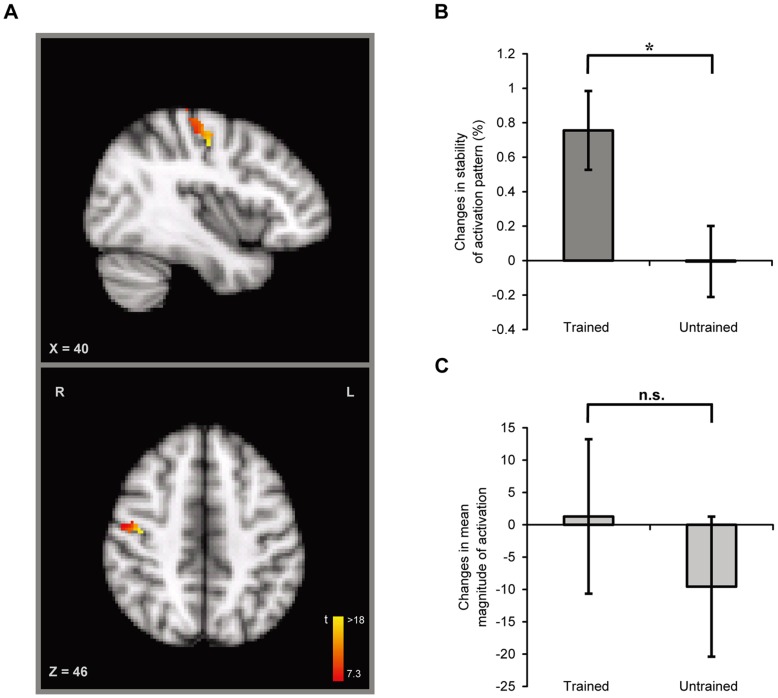
ROI-based Analyses.A) The right primary motor area (M1) that corresponds to the trained left hand from a typical participant (MNI coordinates: x = 40, y = −14, z = 46; t value = 18.3). M1 was defined as the intersection between the functional activation in the localizer scan and the anatomic M1 label in the Juelich Histological Atlas. B) Learning-induced changes in the stability of activation patterns in the M1 for both trained and untrained sequences. C) Learning-induced changes in the mean magnitudes of neural activation for both the trained and untrained sequences. The error bars indicate ±1 S.E.M. An asterisk indicates p<0.05.